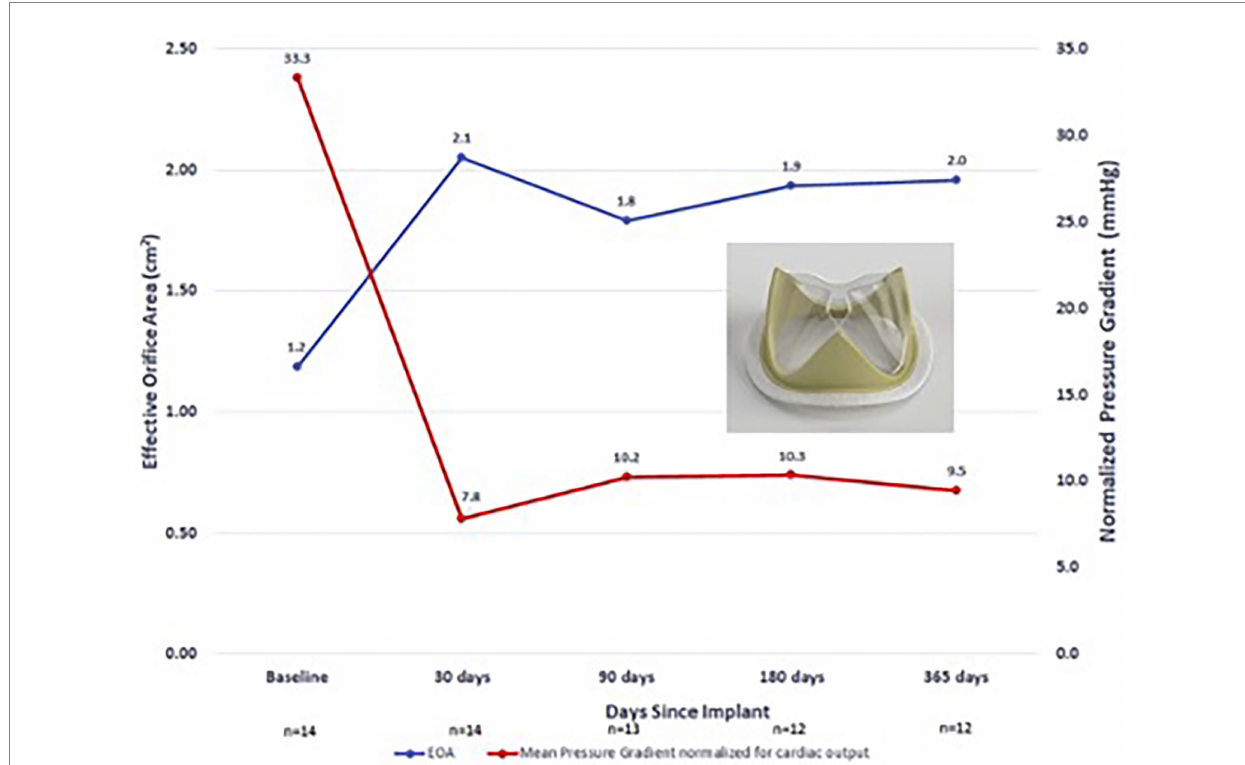
FIGURE 5 Foldax Tria surgical valve early feasibility study in humans—EOA and MPG over 1-year